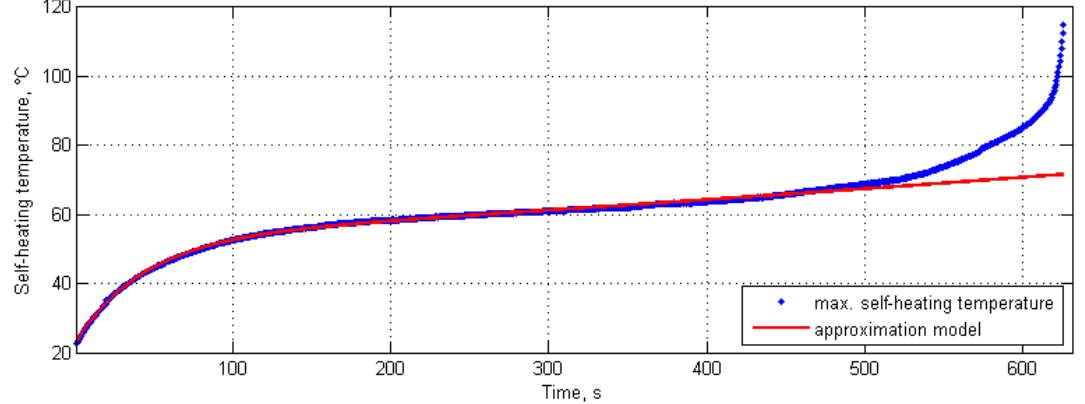
Figure 6. Exemplary self-heating temperature history curve with approximation model.